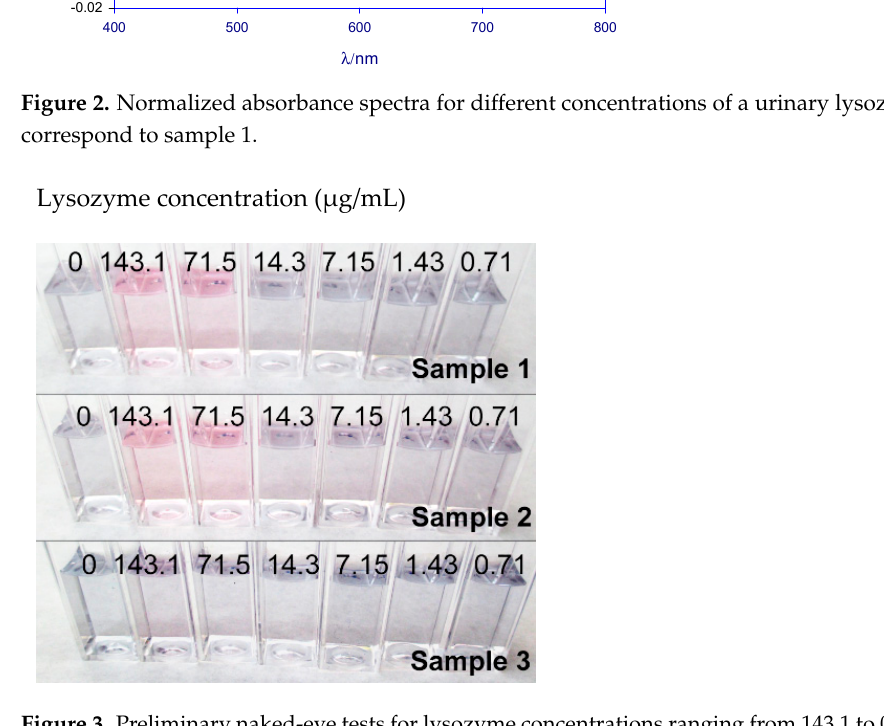
Figure 4. RGB color simulation obtained from experimental L*a*b* parameters corresponding to different lysozyme con- centrations in urine. Blank samples have no urine and no lysozyme.